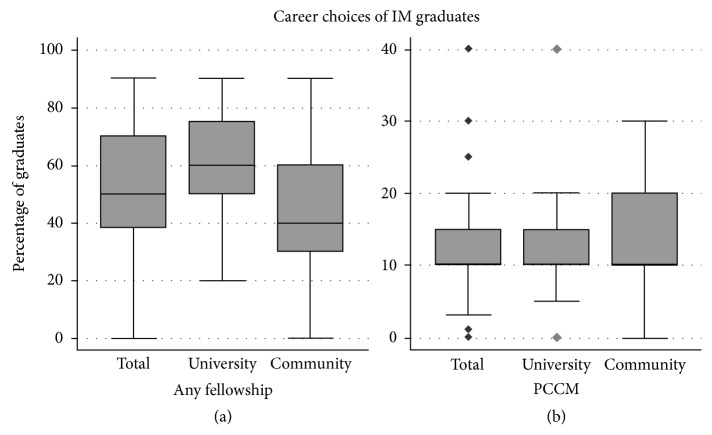
Box and whisker plots depicting the percentage of graduating IM residency classes pursuing any fellowship training (a) and PCCM (b) by residency sponsorship. A significantly higher median percentage of graduates from university-sponsored programs pursued any fellowship (60 (50–75) versus 40 (30–60), p < 0.001), but the class percentages pursuing PCCM specifically did not differ between residency types (10 (10–15) versus 10 (10–20), p < 0.64).